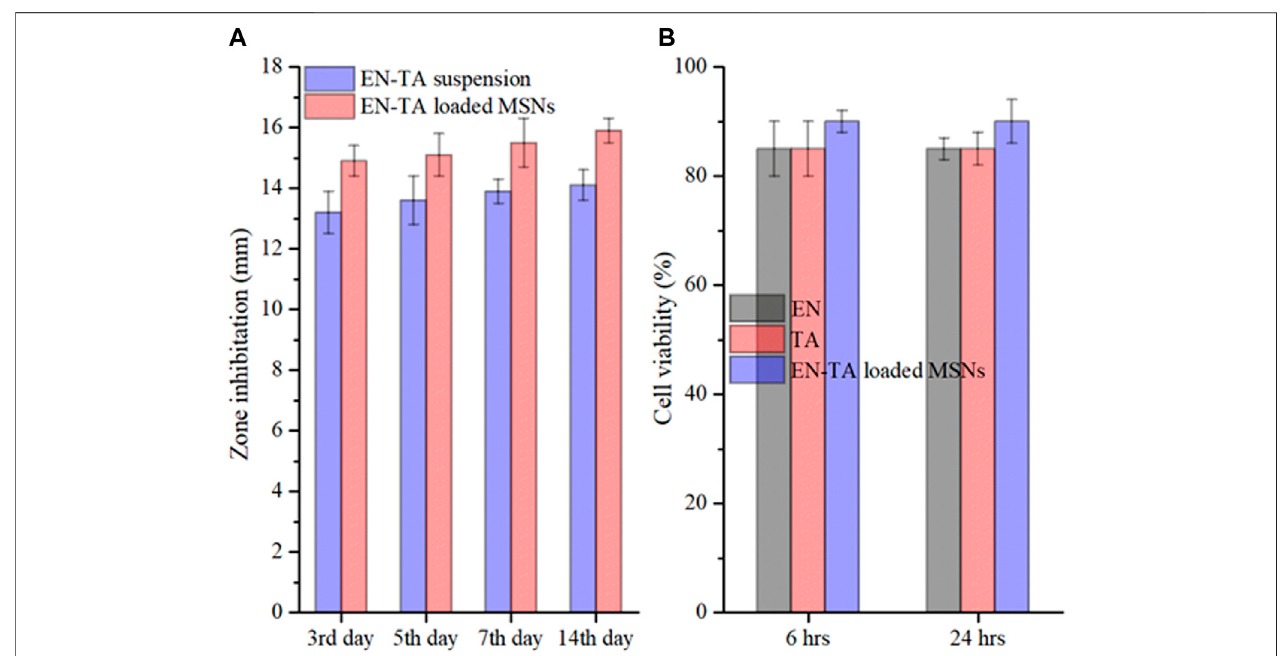
FIGURE 5 | In vitro antifungal study (A) and cytotoxicity study (B) of pure EN-TA suspension and EN-TA loaded MSNs.